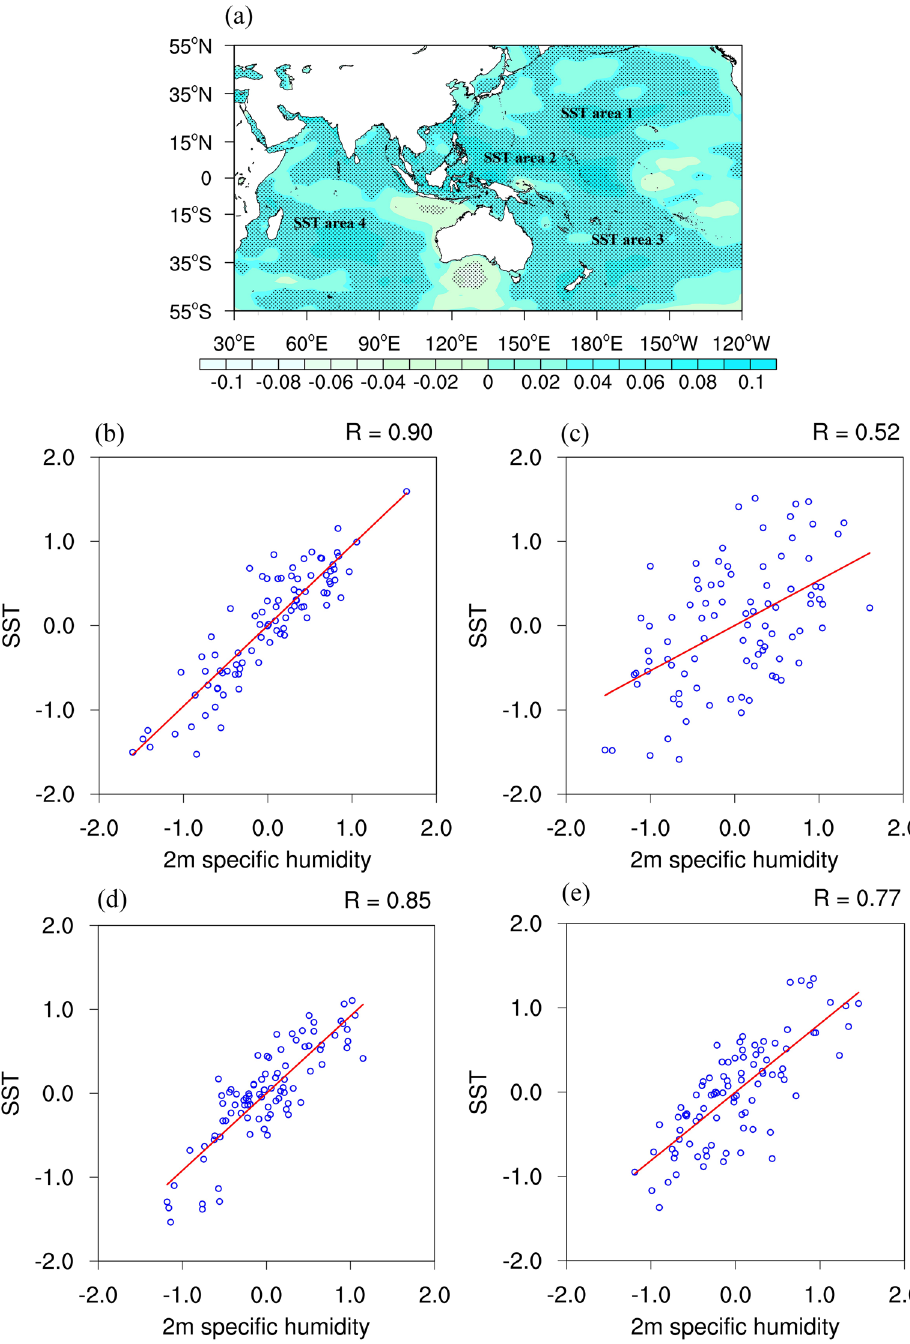
Figure 2. Summer of 1991–2020: ( a ) distribution characteristics of the global specific humidity variability at 2 m (g/kg/year; values over the 90% confidence level based on the student t-test are stippled). ( b–e ) Standardized scattered point distribution of specific humidity at 2 m and SST in the SST high-impact areas from June to August; ( b ) SST area 1, ( c ) SST area 2, ( d ) SST area 3, and ( e ) SST area 4. The maps were generated with NCAR Command Language (NCL) Version 6.2.1 (http:// www. ncl. ucar.